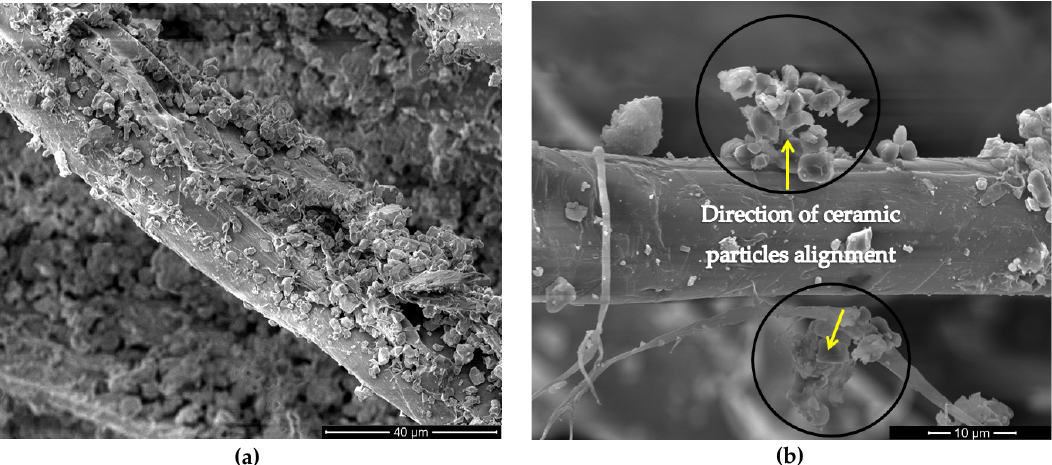
Figure 9. SEM images of the fracture surface of the PALF composite after the ballistic test: ( a ) PALF impregnated with ceramic aggregates; ( b ) alignment of ceramic aggregates on PALF surface.